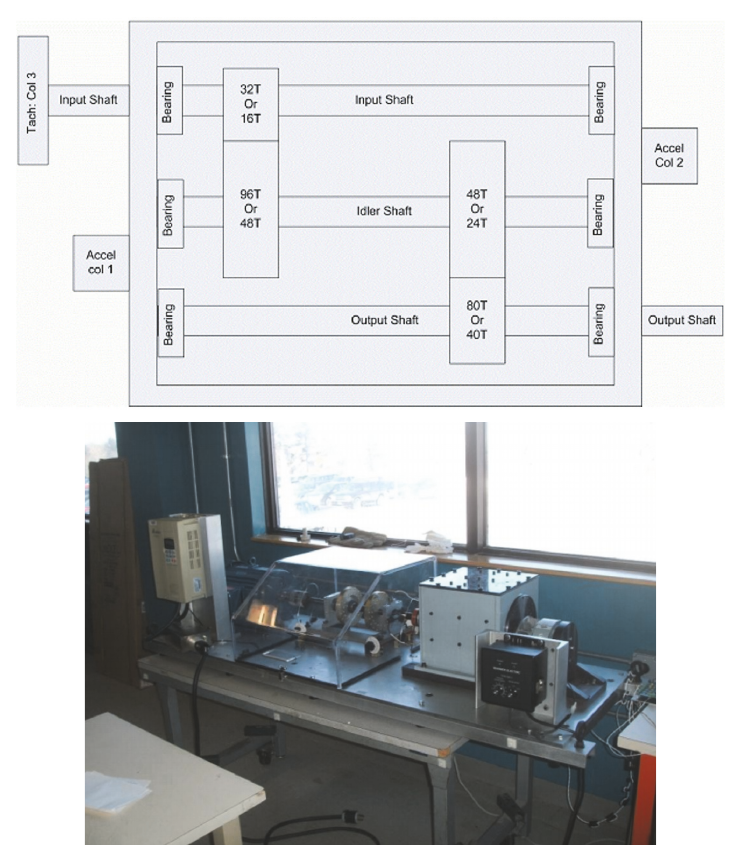
Figure 2: Schematic and overview of the gearbox used in PHM 2009 Challenge Data [18].